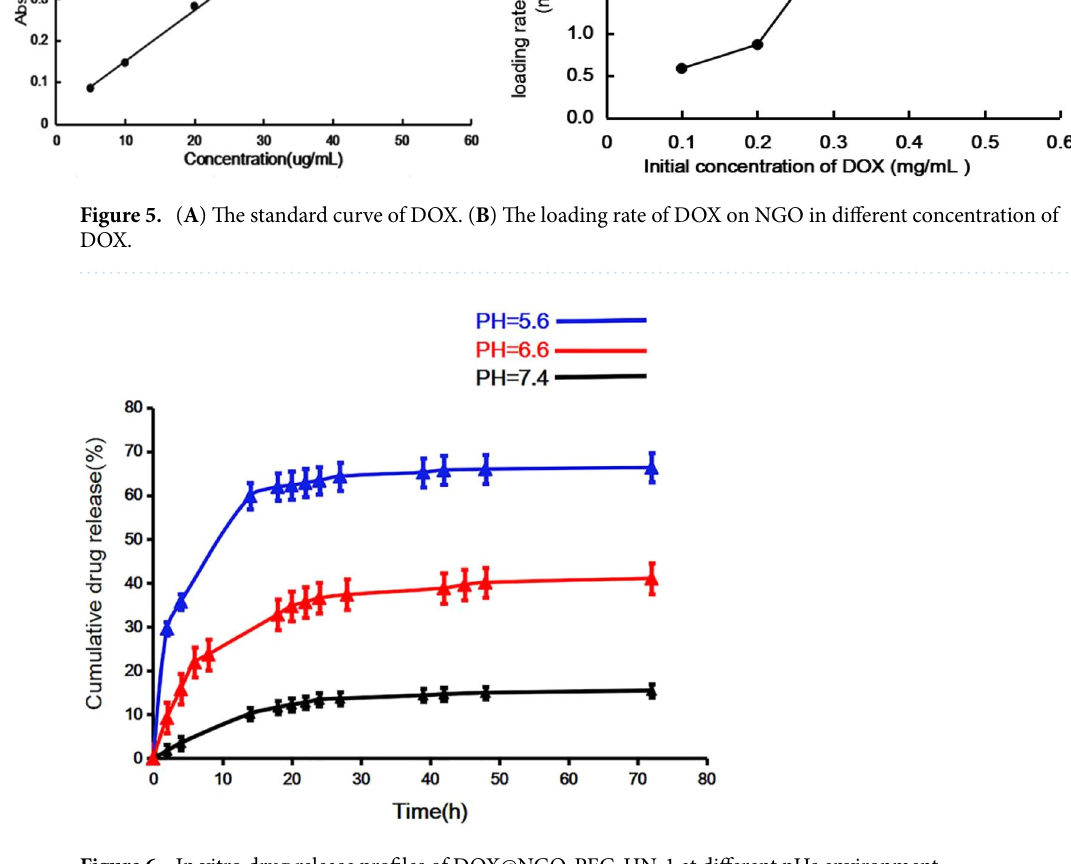
Figure 6. In vitro drug release profiles of DOX@NGO-PEG-HN-1 at different pHs